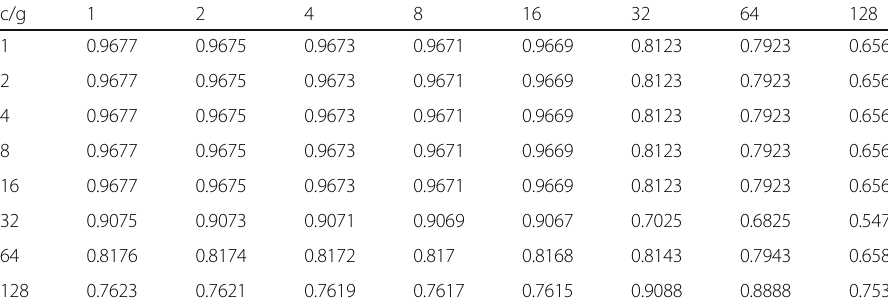
Table 2 DWSVM model mesh optimization algorithm _ G